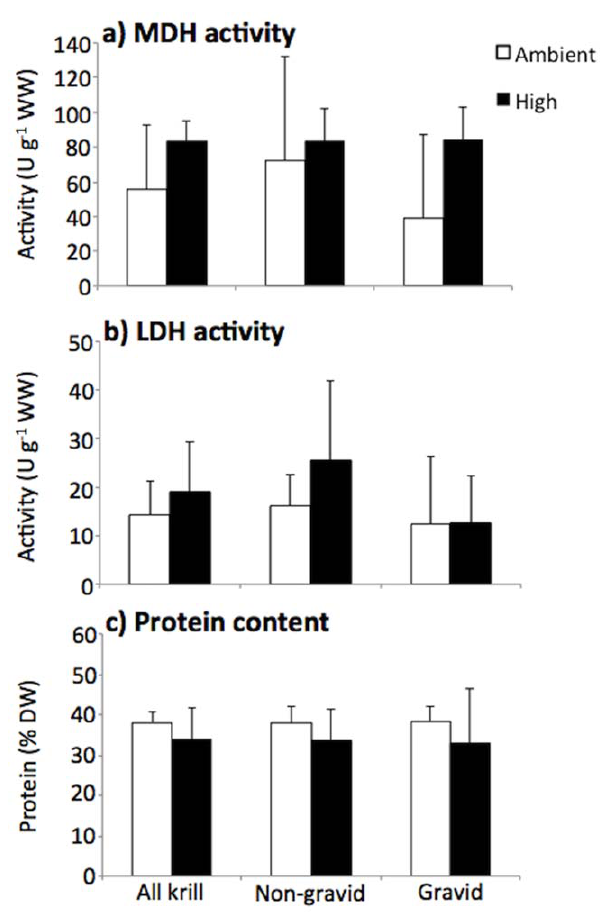
Figure 4. Euphausia superba metabolic enzyme activity and protein content. Malate dehydrogenase activity (MDH; a), lactate dehydrogenase activity (LDH; b), and protein (c) of krill exposed to ambient and high ( (cid:2) xx =672 ppm) concentrations of CO 2 . Mean of n=3 for non-gravid and gravid krill and n=6 for all krill; error bars=2 6 standard error.